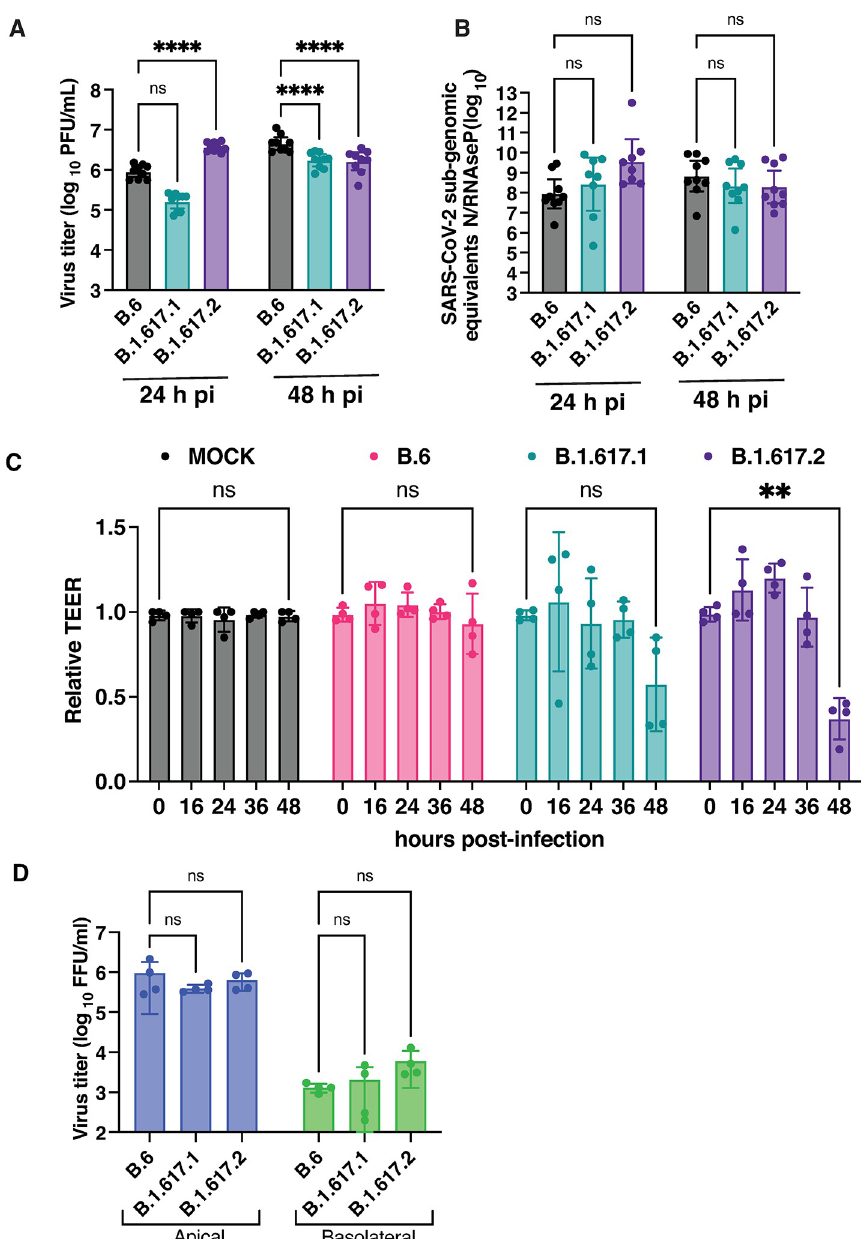
Fig 1. Growth curve analysis of B6, B.1.617.1, and B.1.617.2 variants in Calu-3 cells. Calu-3 cells were infected with 0.01 MOI of SARS-CoV-2 virus B.6, B.1.617.1 (Kappa), and B.1.617.2 (Delta) variants. (A) Virus titer in the culture supernatant collected at indicated time-points were estimated by plaque assay. Error bars represent geometric mean with 95% CI. (B) Sub-genomic RNA of N gene was estimated by qRT-PCR. RNAse P was used as internal control for normalization. Error bars represent geometric mean with 95% CI. (C) Calu-3 cells grown on transwell inserts were infected with above variants at 0.3 MOI and TEER was monitored at indicated time points. Values (Mean ± SD) are represented as relative to time zero before infection and statistical significance was determined by comparing the zero hour and 48 h readings by two-way ANOVA with Dunnett’s multiple comparisons test. (D) Viral titers were measured in supernatants at 48 h pi by focus-forming units. Data are from two or three independent experiments (Mean ± SD). ns: non-significant; �� P < 0.01; ���� P < 0.0001.